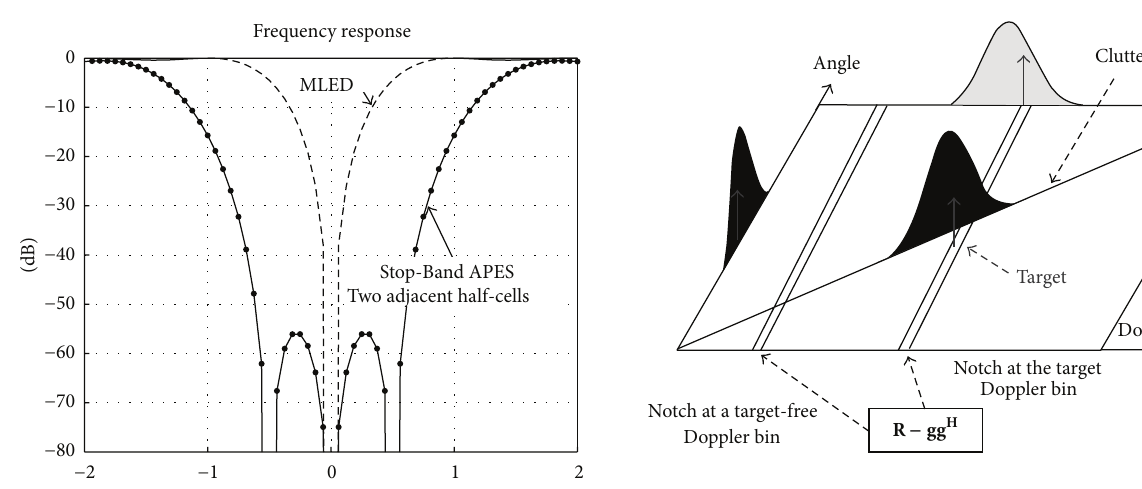
Figure 2: Angle-Doppler map showing the effect of MLED projec- tor for two different Doppler